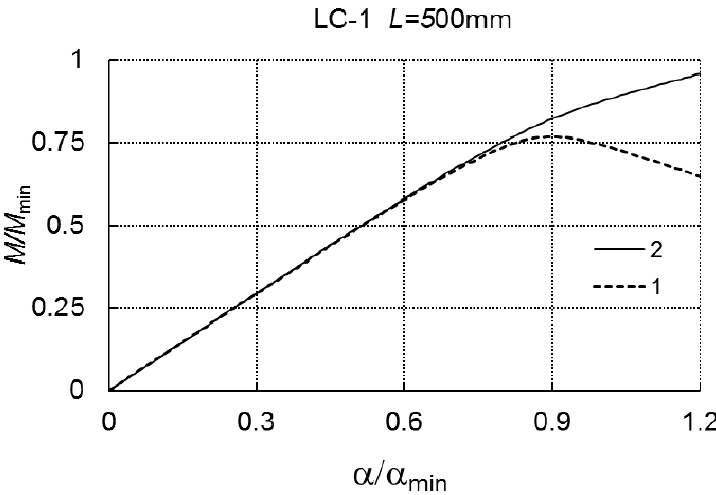
Figure 5. M / M min as a function of α / α min for LC-1 and L = 500 Figure 5 . M/M min as a function of α / α mi n for LC-1 and L = 500 mm.